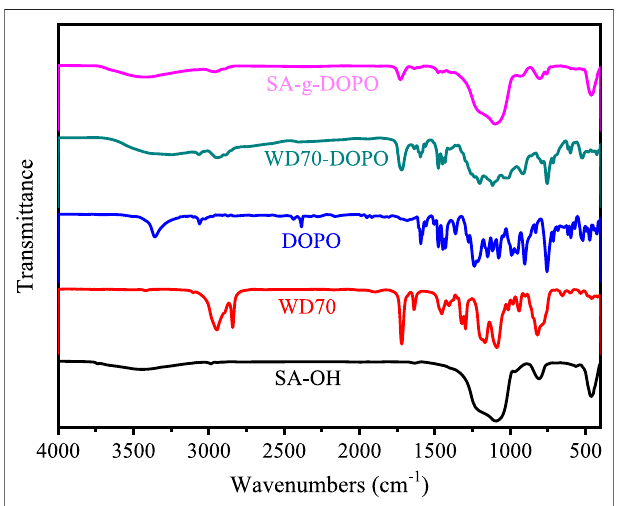
FIGURE 3 | FTIR spectra for SA-OH, WD70, DOPO, WD70-DOPO, and SA-g-DOPO.